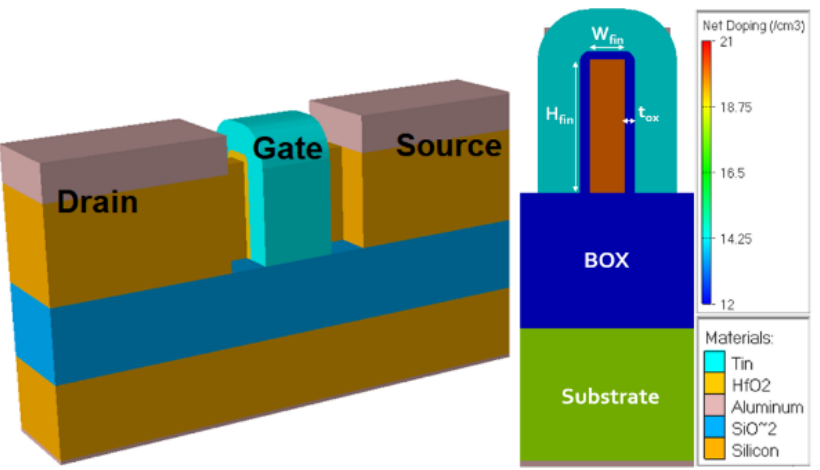
Figure 1. Structure of 3D 14-nm SOI n-FinFET device with a single fin.